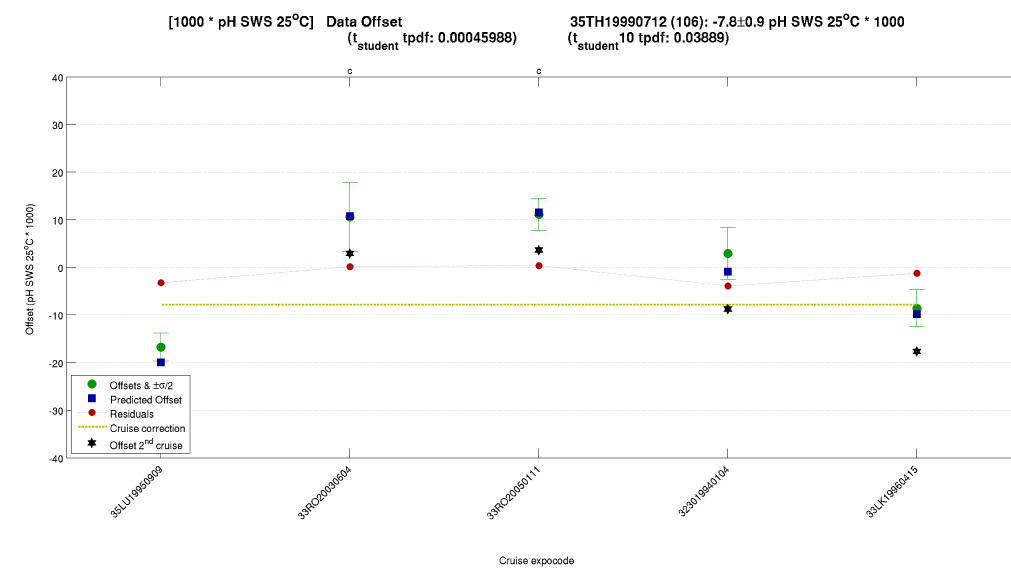
Figure 17. Cruise crossover information plot for 35TH19990712 (106).